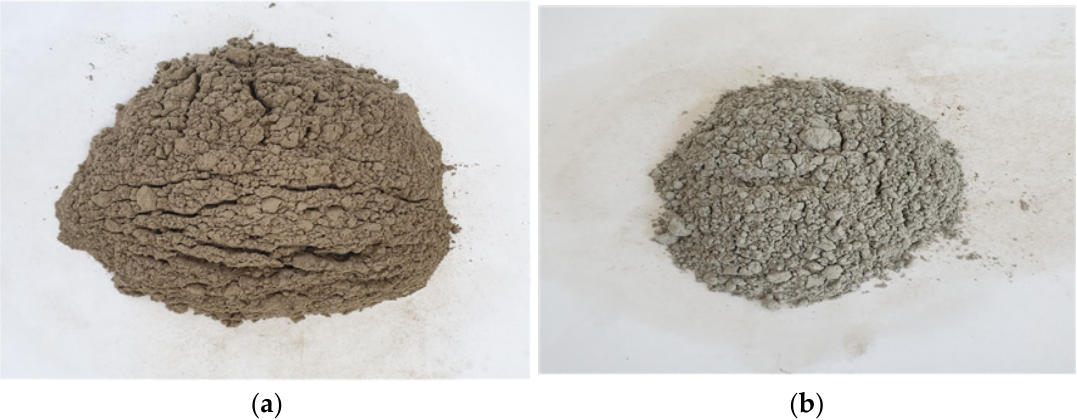
Figure 1. Fly ash and ferronickel-slag powder sample: ( a ) fly ash, ( b ) ferronickel-slag powder.